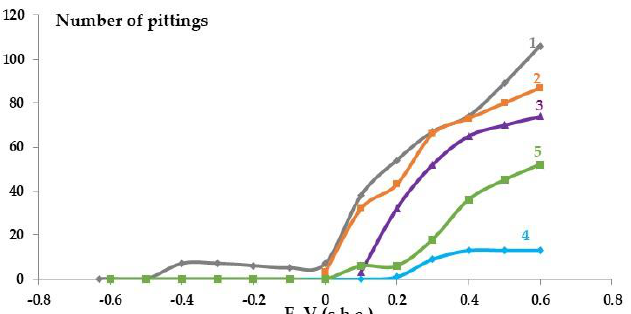
Figure 7. Effect of anodic potential on the development of the pitting dissolution of carbon steel. 1—non-modified steel, 2—steel modified with a VS solution; 3—steel modified with an AS solution; 4—steel modified with a solution of a (VS + BTA) mixture; 5—steel modified with a solution of a (VS + AS) mixture. Conditions of recording the anodic polarization curve (Figure 3): 0.1 M solution NaCl. Potential scan rate: 1 mV/s.